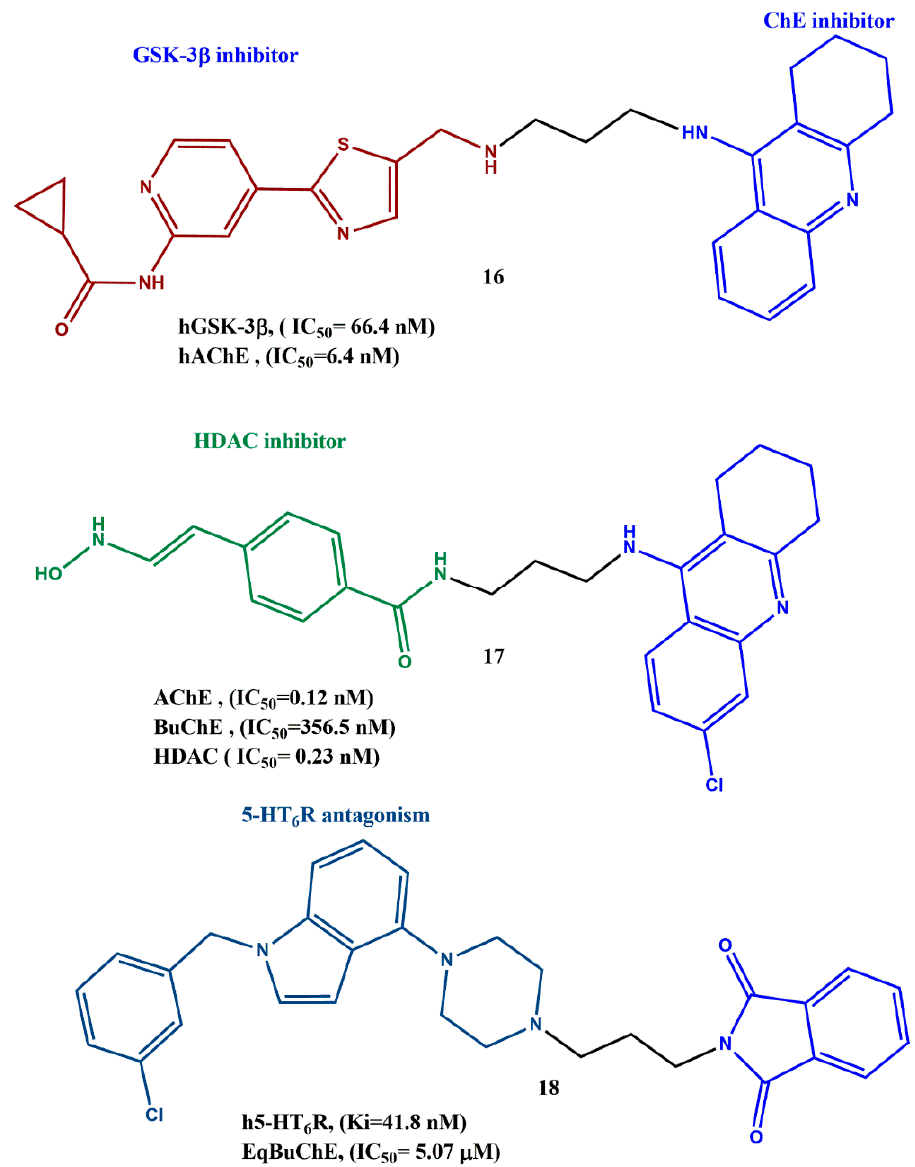
Figure 7. Examples of MTDLs for diverse AD